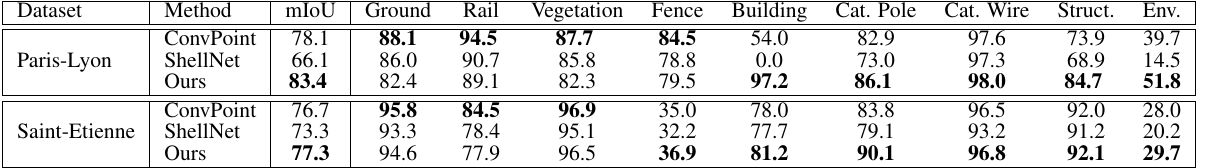
Table 2. Segmentation performances in mIoU (%) by class on Paris-Lyon and Saint-Etienne datasets tion, the spatial distribution of objects within the dataset has a strong impact on the segmentation performances, especially in the case of statistically unbalanced dataset.